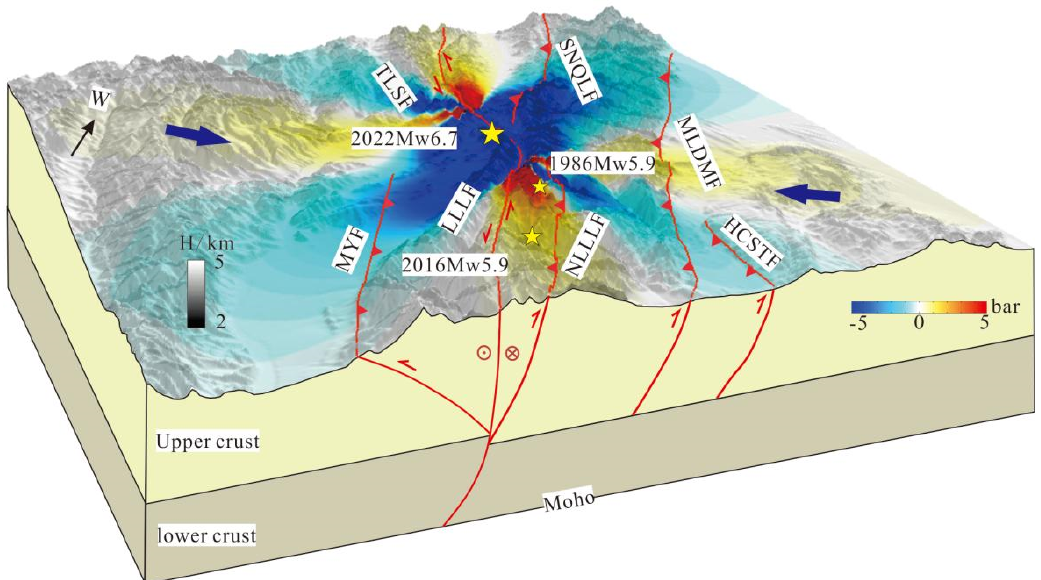
Figure 9. Flower structure of the Lenglongling fault. The fault location and regional crustal structure are from [82]. Blue arrow indicates the orientation of regional maximum principal compressive stress [84]. The regional Coulomb stress based on the 2022 Menyuan earthquake as the source fault and the Lenglongling fault as the receiver fault. MYF: Menyuan fault. TLSF: Tuolaishan fault. LLLF: Lenglongling fault. SNQLF: SuNan-Qilian fault. NLLLF: Northern Lenglongling fault. MLDMF: Minle-Damaying fault.